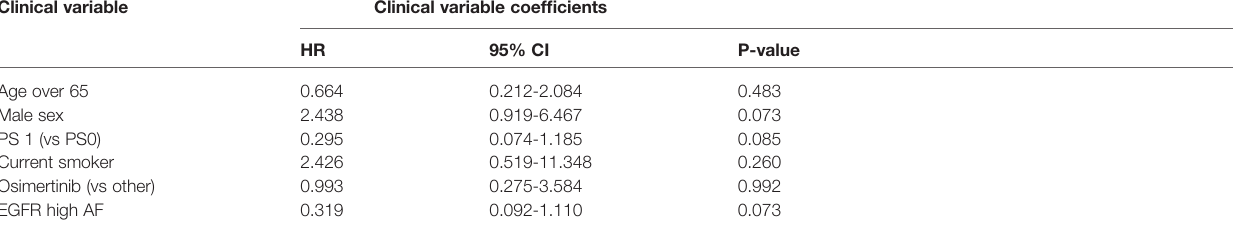
TABLE 1D | Multivariable